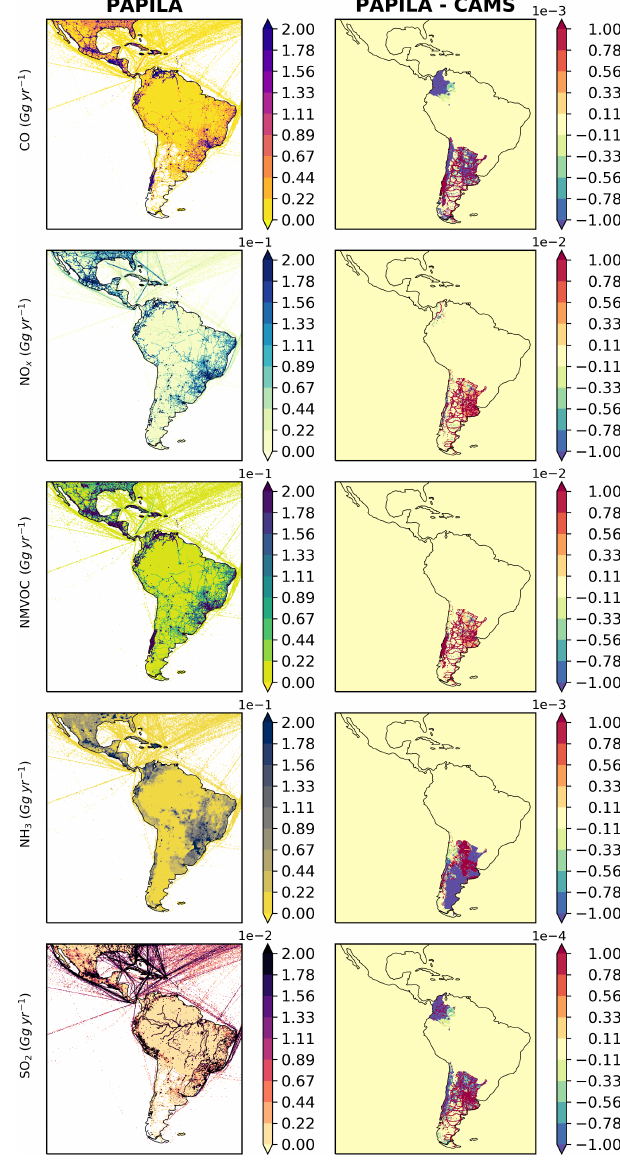
Figure 4. (left) Spatial distribution of 2015 PAPILA emissions (Ggyr − 1 ) and (right) difference between PAPILA and CAMS in- ventories by species in